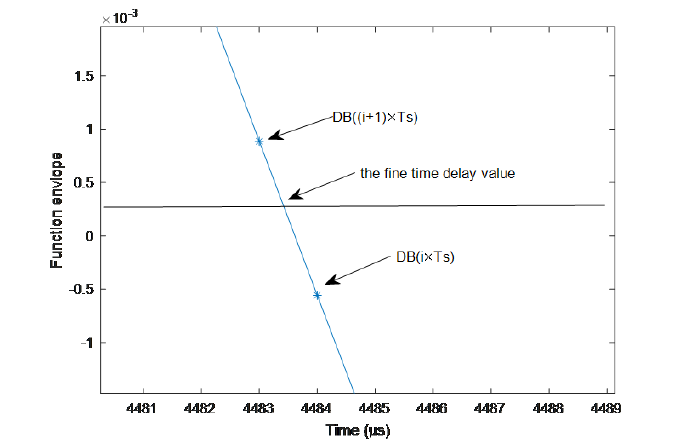
Figure 5. Schematic diagram of two-point linear approximate exact solution time